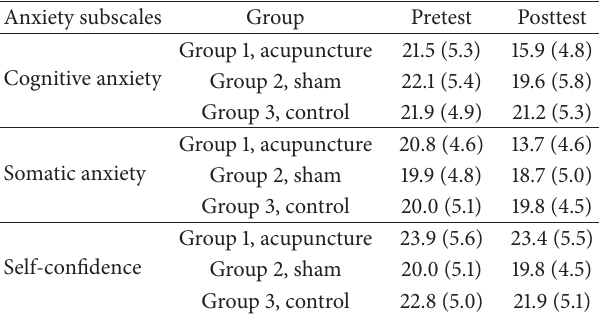
Table 3: Competitive state anxiety for athletes in pre- and postin-